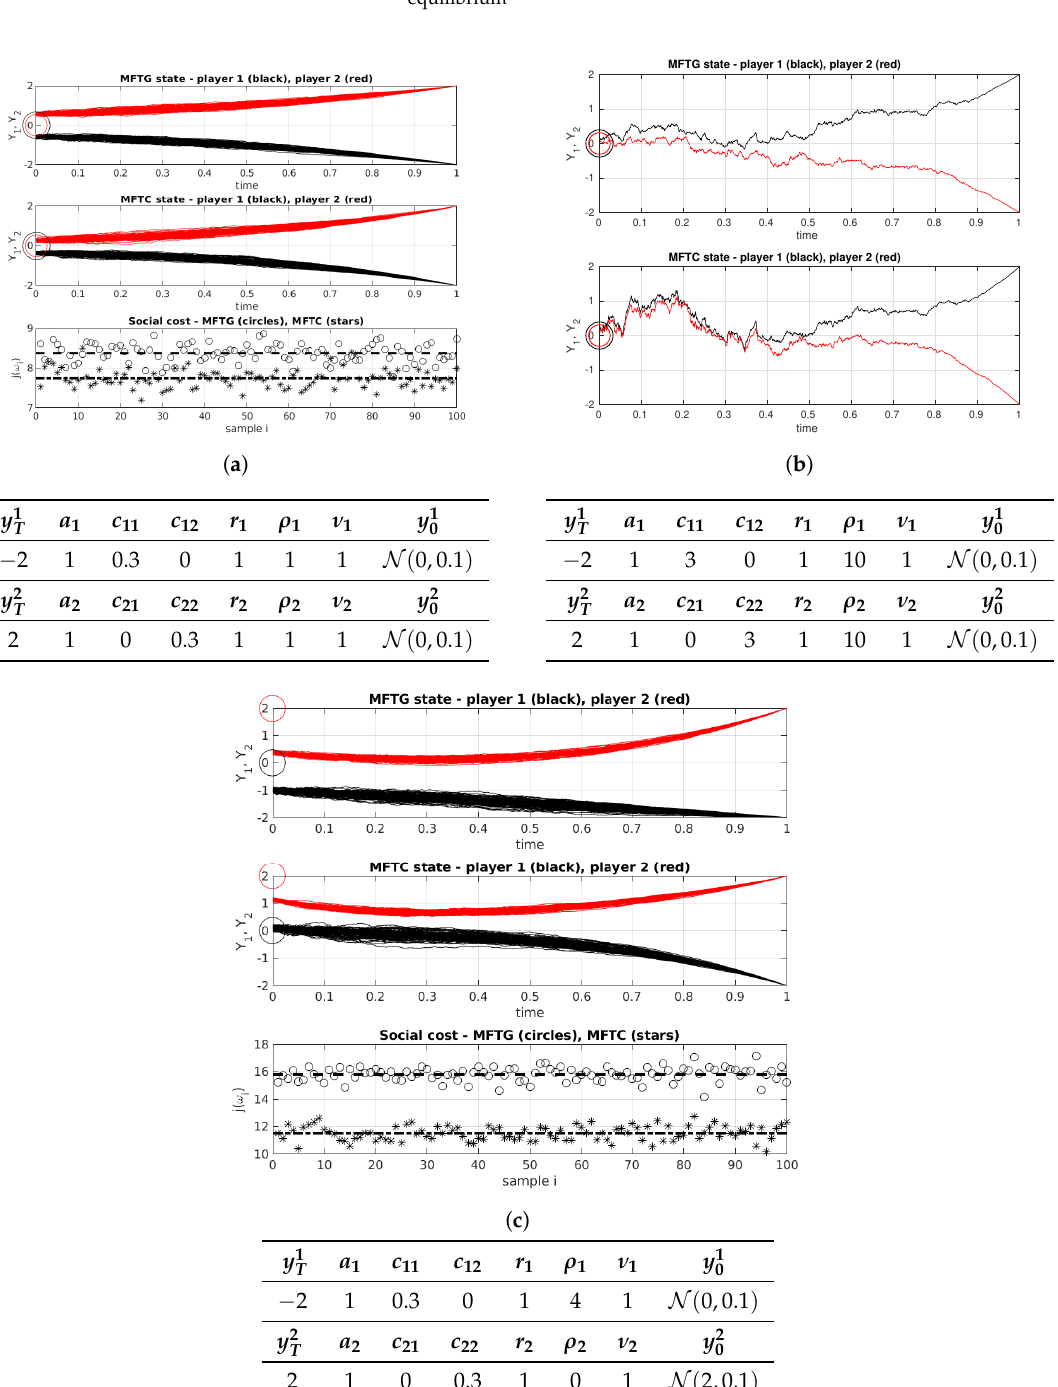
Figure 1. Numerical examples: ( a ) symmetric preference, ( b ) single path sample, ( c ) asymmetric attraction and initial position. Circles indicate the preferred initial